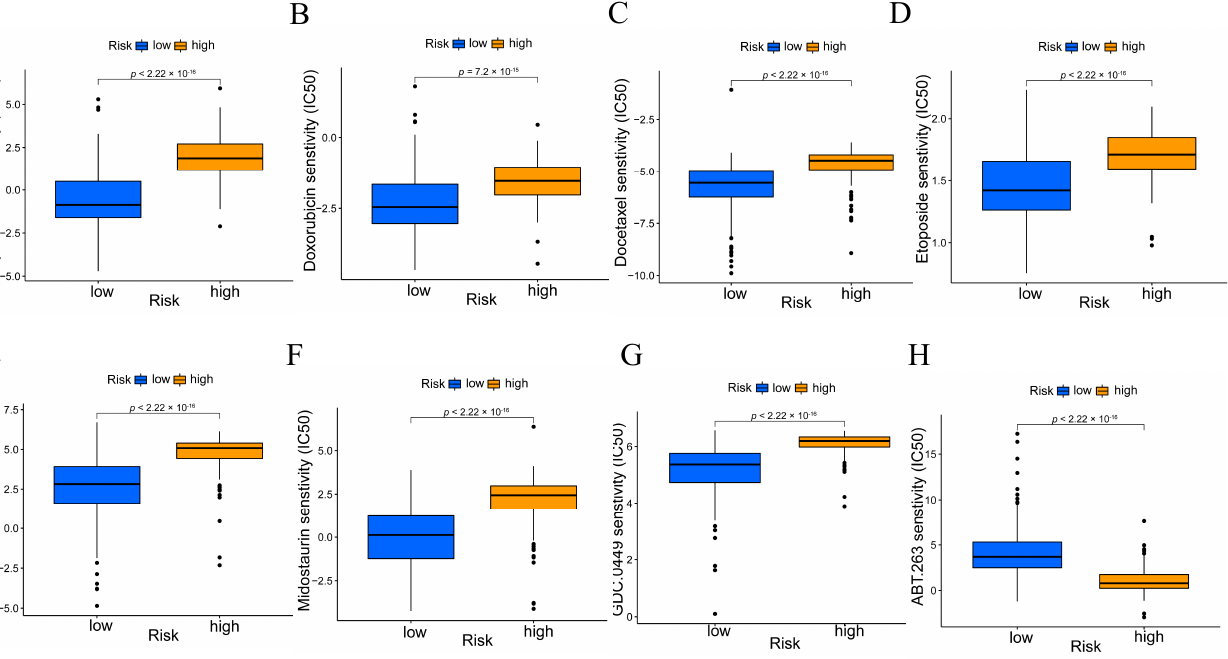
Figure 9. The correlation between different risk groups and drug sensitivity in AML patients. ( A ) Cytarabine; ( B ) Doxorubicin; ( C ) Docetaxel; ( D ) Etoposide; ( E ) Sorafenib; ( F ) Midostaurin; ( G ) GDC-0449; ( H ) ABT-263. IC50, half maximal inhibitory concentration, in